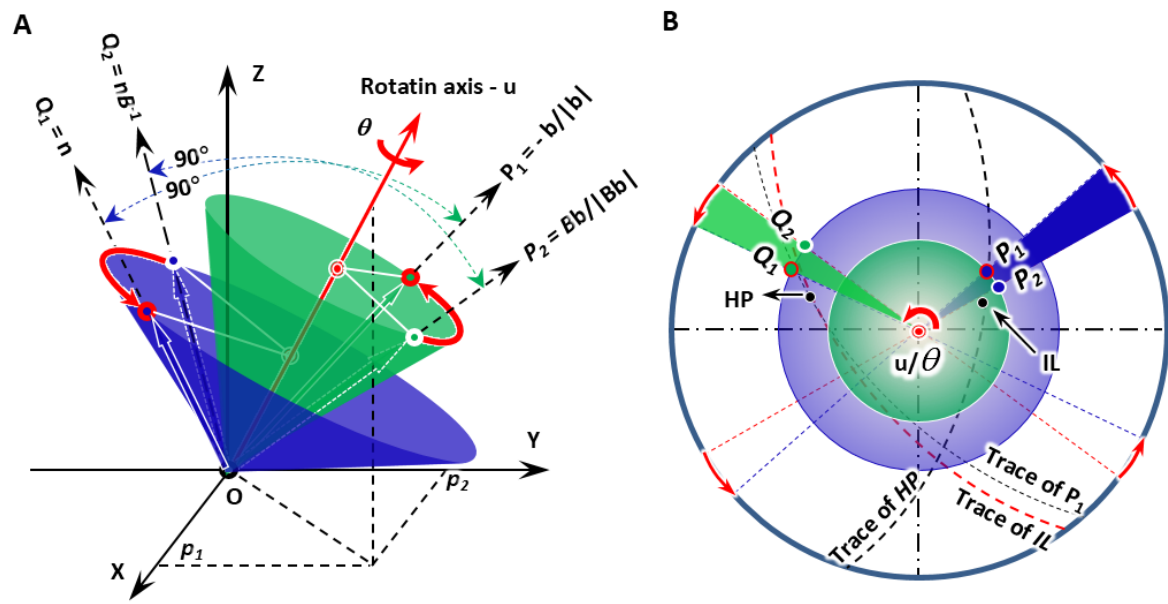
after rotation, respectively.